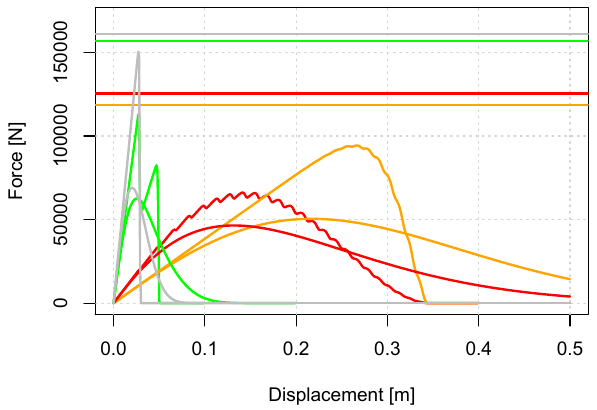
Fig. B1. Sensitivity analysis of the displacement-force curve of root bundles considering different root distribution (red=RD1 in Fig. 6, orange=RD3 in Fig. 6, green= two root diameter class distribu- tion, gray=one root diameter class distribution) with a constant root area ration (RAR) equal to 0.01, calculated with the RBMw and the Wu model. For the calculation with the RBMw a value of 2 (lower curve) and 100 (upper curve) were used for the exponent ω